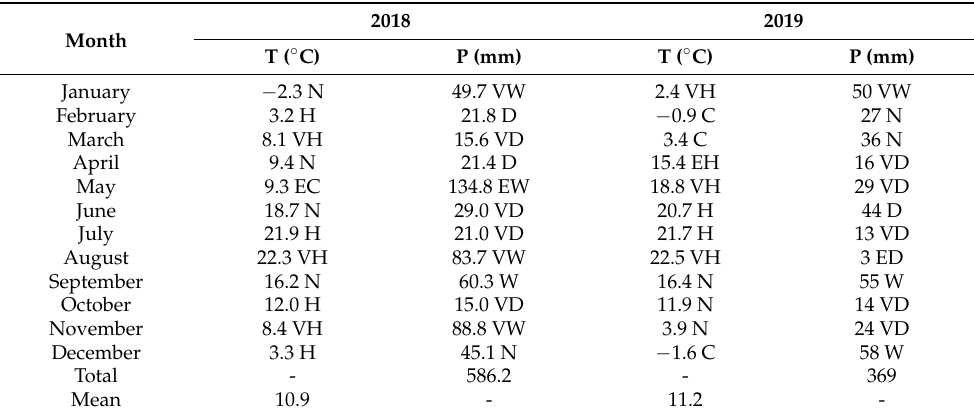
Table 1. Average temperature (T) and sum of precipitation (mm) within vegetation period in 2018 and